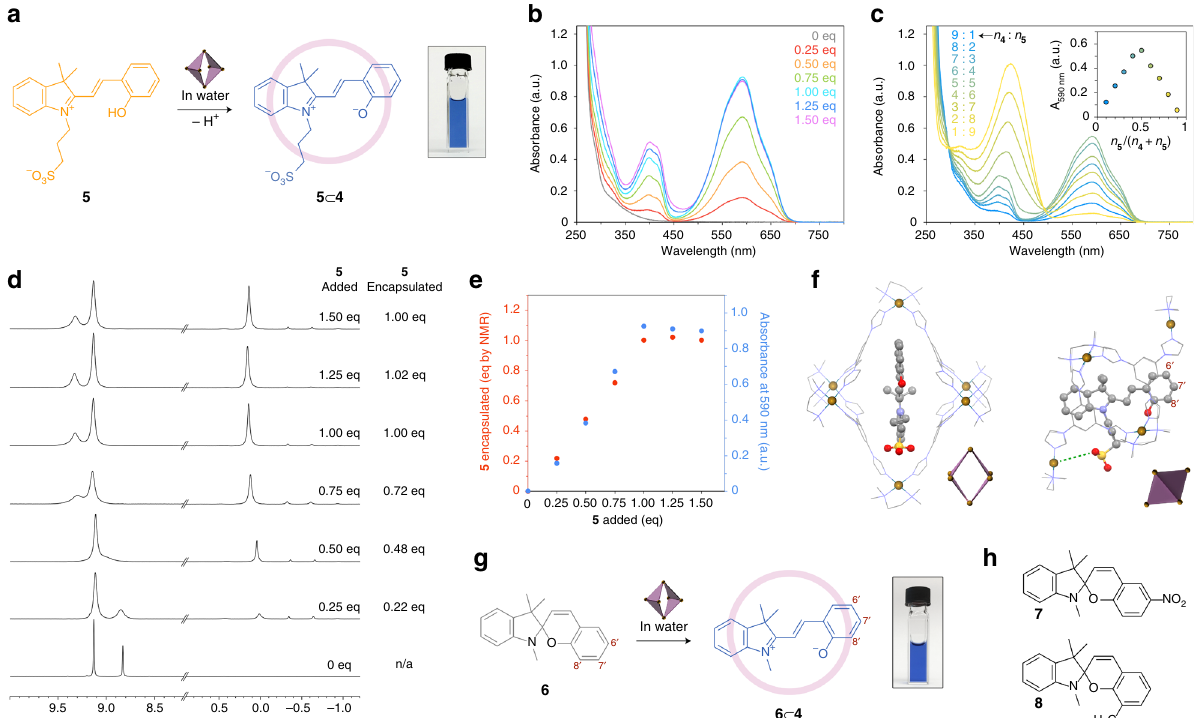
Fig. 2 Encapsulation of a spiropyrans within a self-assembled cage. a Encapsulation-induced deprotonation of 5 . b Changes in the UV/Vis absorption spectra of 4 upon titrating with 5 (all spectra were recorded once equilibrium was reached). c UV/Vis absorption spectra of an aqueous solution containing different molar ratios of 4 / 5 at the same total concentration of the two species. The resulting Job ’ s plot reveals that the 4 – 5 complex has a 1:1 stoichiometry. d Partial 1 H NMR spectra (400 MHz, D 2 O) of 4 in the presence of increasing amounts of 5 . The down fi eld-shifted signals correspond to 4 ’ s imidazole protons. The up fi eld-shifted signals are due to the methyl groups of encapsulated 5 (eq = equivalent). e Following the binding of guest 5 by cage 4 using UV/Vis absorption spectroscopy and NMR (replotted from b and d ). f Two views of the X-ray crystal structure 5 ⊂ 4 (the cartoons show the orientation of the cage). The hydrogen atoms were removed for clarity. g The 4 -induced ring-opening isomerization of spiropyran 6 . h Structural formulas of spiropyrans 7 and 8 investigated as potential and the solution turned from blue to yellow (the crystals of 5 ⊂ 4 were pale yellow). To quantify these changes, we recorded a series of UV/Vis spectra of 5 ⊂ 4 at concentrations spanning three orders of magnitude (Supplementary Fig. 44). Representative spectra of the same solution at two different concentrations are shown in Fig. 3a. Upon concentrating the solution from ~0.3 mM to ~5 mM, the absorption band at ~592 nm (due to the MC form) decreased at the expense of an intense peak at ~460 nm. This change in color was reversible and by diluting the solution, the original spectrum could be restored. Figure 3b shows the dependence of absorbance at two different wavelengths as a function of the solution concentration. Absorbance at 345 nm is proportional to the total amount of 5 ⊂ 4 (i.e., all isomers of 5 ) and it shows a linear dependence on concentration, following the Lambert – Beer law. However, the absorbance at 592 nm — a region where only the MC isomer absorbs — decreased at high con- centrations. This decrease is at the expense of MCH + , which is the species that absorbs strongly at ~460 nm. These color changes are a manifestation of the well-known property 56 of weak acids (here, MCH + ) to dissociate to a greater extent in dilute solutions (Fig. 3c). Interestingly, no color changes were observed upon diluting a solution of 5 in the absence of 4 , emphasizing the unique role of the cage in stabilizing the MC isomer of 5 .